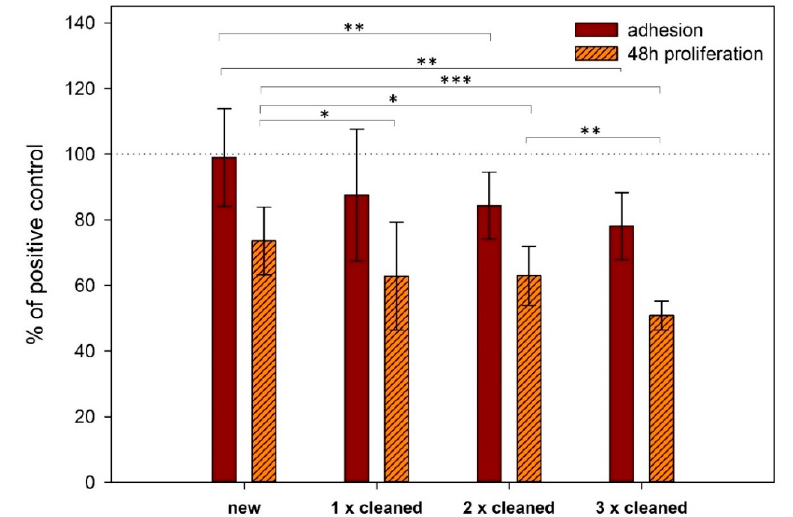
Figure 2. Comparison of cell adhesion and proliferation on the surface of new and different times cleaned titanium samples assessed by CCK-8 assay. The standard errors were calculated from all measurements (new—20 samples, 1× cleaned—15 samples, 2× cleaned—10 samples and 3× cleaned—5 samples). Data expressed as a percentage of positive control. Error bars indicate means ± standard deviations. Asterisks represent statistical significance between respective groups (* p < 0.05, ** p < 0.01, *** p < 0.001).